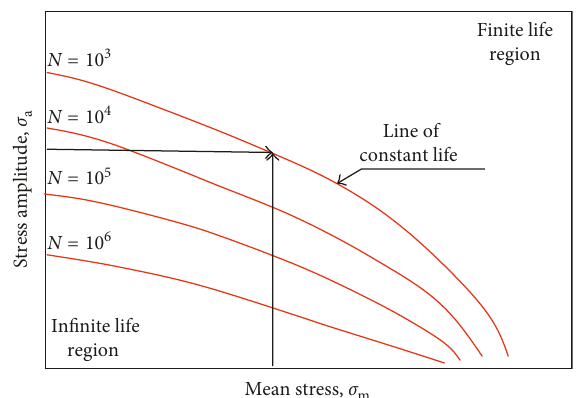
Figure 1: Example of a Haigh diagram for fatigue life